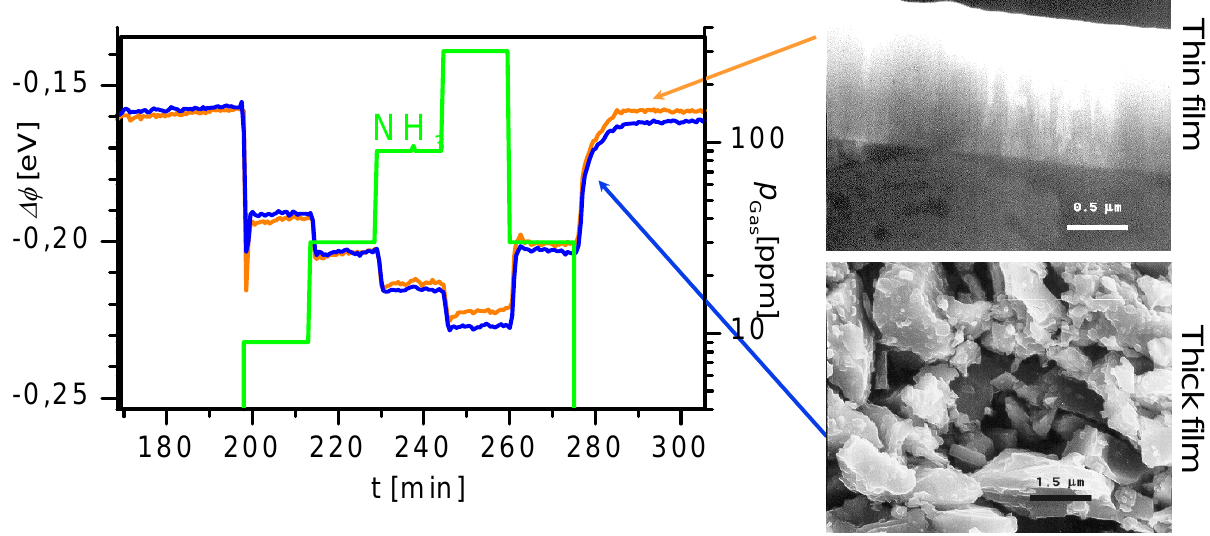
Figure 15. Work function change of two different preparations of TiN at room temperature exposure in wet synthetic air measured with the Kelvin in response to NH 3